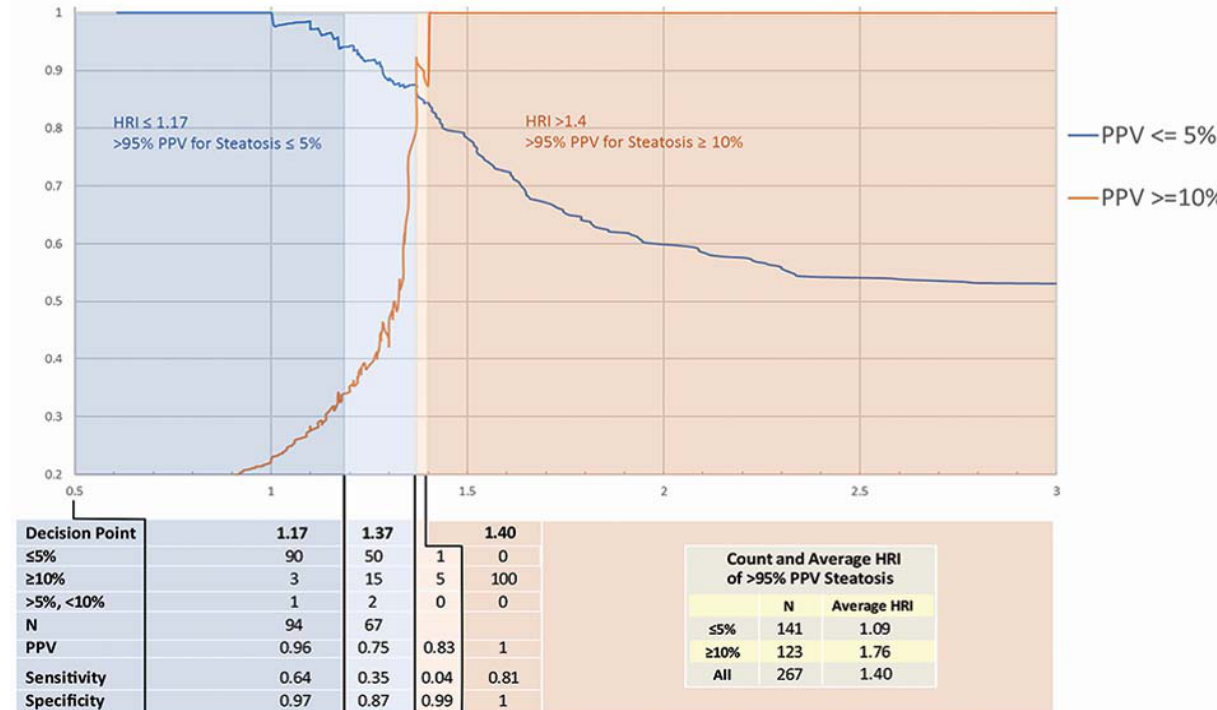
Figure 3. Positive predictive value for steatosis based on HRI.